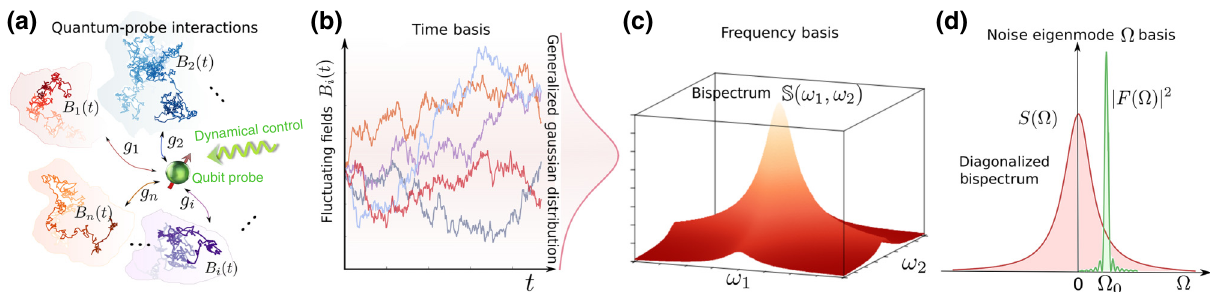
FIG. 1. Representation of the qubit-probe interaction with fluctuating fields derived from the path integral framework. (a) Schematic representation of a qubit-probe interacting with the fluctuating fields B i ( t ) that generate pure dephasing. The system-bath coupling strengths g i are dynamically controlled. The index i labels properties of the qubit-bath coupling network morphology. (b) Representa- tion of the fluctuating field paths B i ( t ) that give a generalized Gaussian distribution that is sensed by the quantum probe as a function of time. The fluctuating fields are described in the time basis | t ) . (c) Frequency basis | ω) representation of the fluctuating field correlation functions, which provides a bidimensional, nonstationary noise spectrum S (ω 1 , ω 2 ) = (ω 1 | G | ω 2 ) . (d) Noise eigenmode (cid:4) -basis rep- resentation of the nonstationary, generalized noise spectrum S ((cid:4)) (red solid line), obtained after diagonalization of the noise spectrum in the frequency basis. A generalized filter function F ((cid:4)) in the noise eigenmode (cid:4) basis is shown with a green solid line. Here, it mainly probes a single noise eigenmode (cid:4) 0